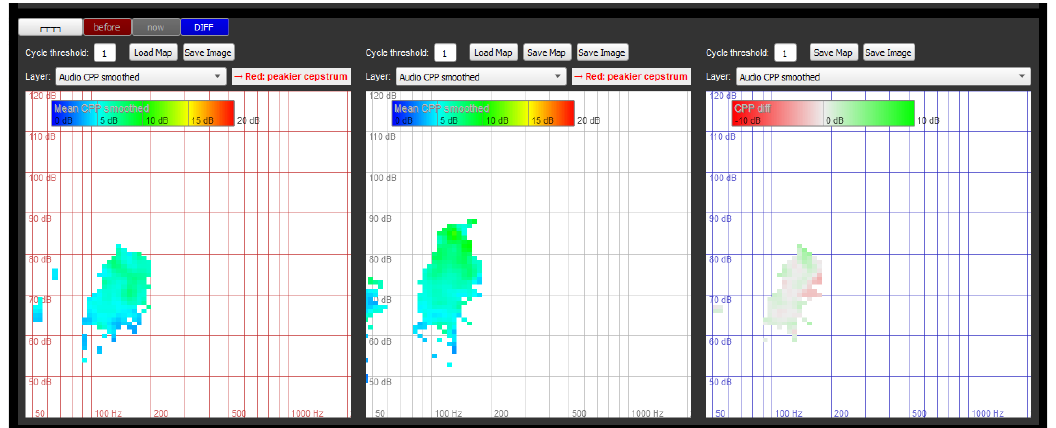
Figure 3. Voice maps of Smoothed Cepstral Peak Prominence (CPPS) (dB) values for one male patient with cysts during text reading before ( left ) and after ( middle ) surgical treatment, plotted with the software FonaDyn. The ( right ) figure shows the differences between pre- and post-measurements. This figure illustrates that voice function varies by voice fundamental frequency and intensity. (Figure: provided by S. Ternström, based on one individual from